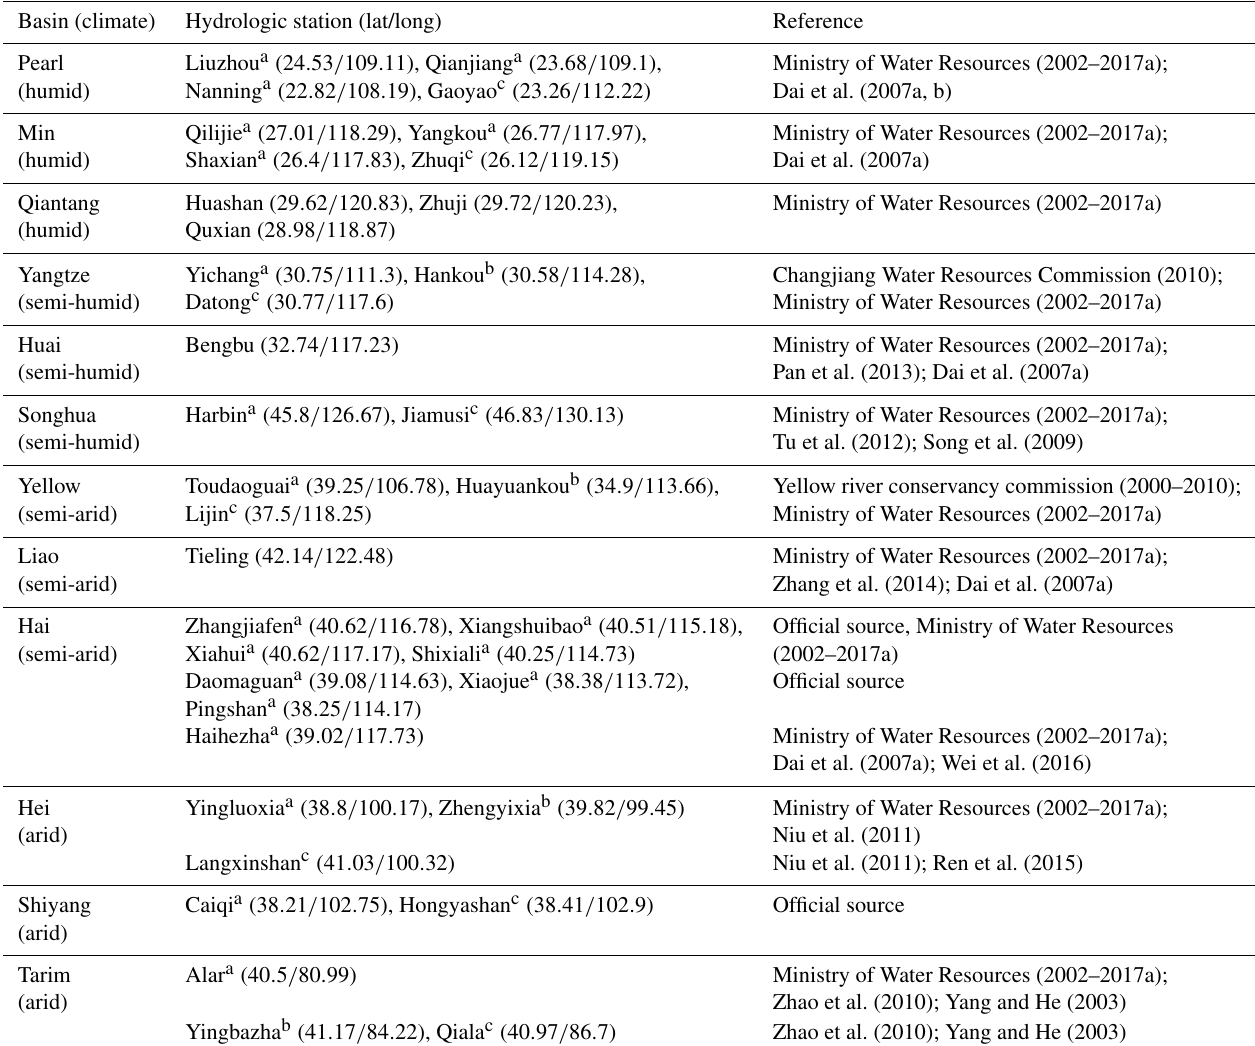
Table 1. Sources of hydrological data and locations of runoff